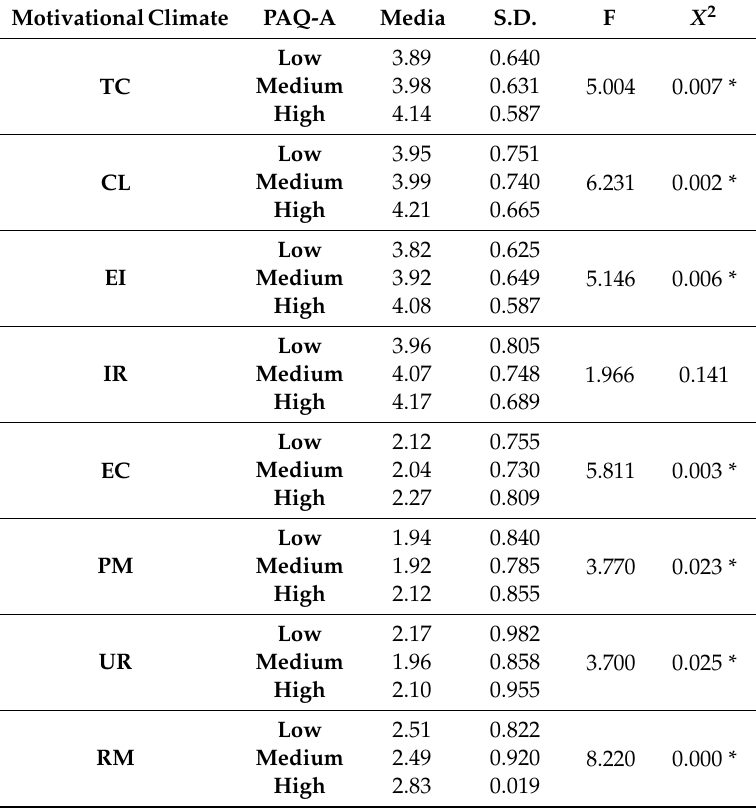
Table 1. Motivational climate and physical activity level. MotivationalClimate